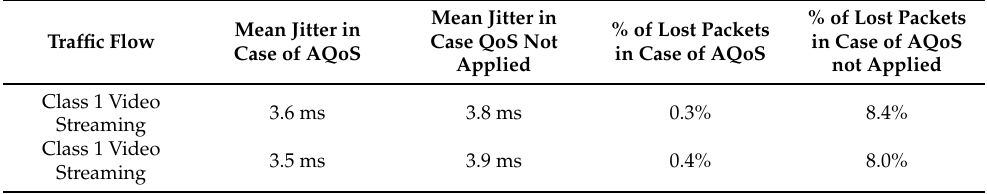
Table 7. Scenario 1 Video Streaming Performance Results.